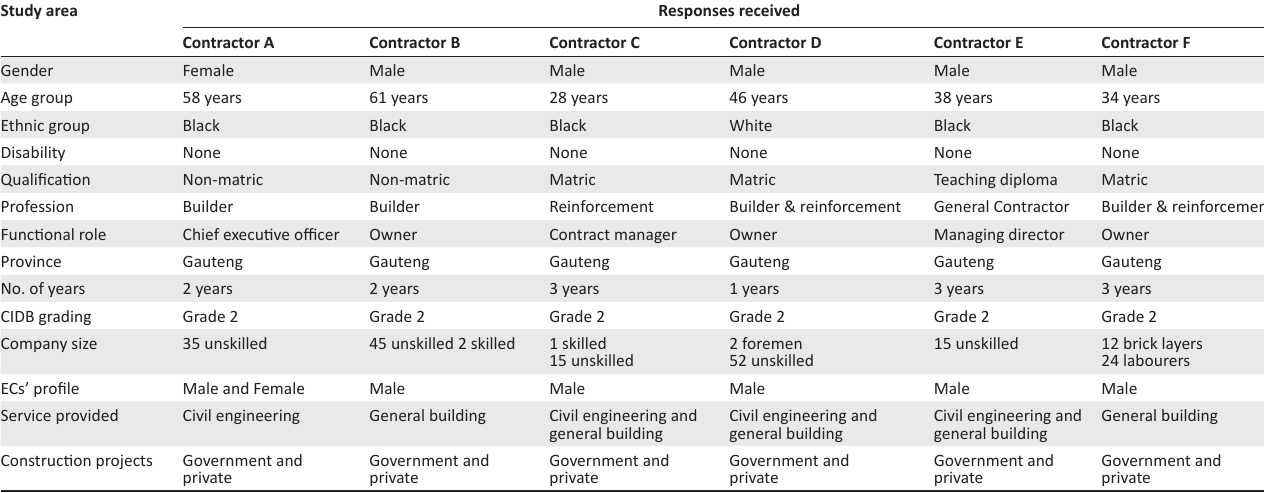
TABLE 1: Profile of key informants. Study area